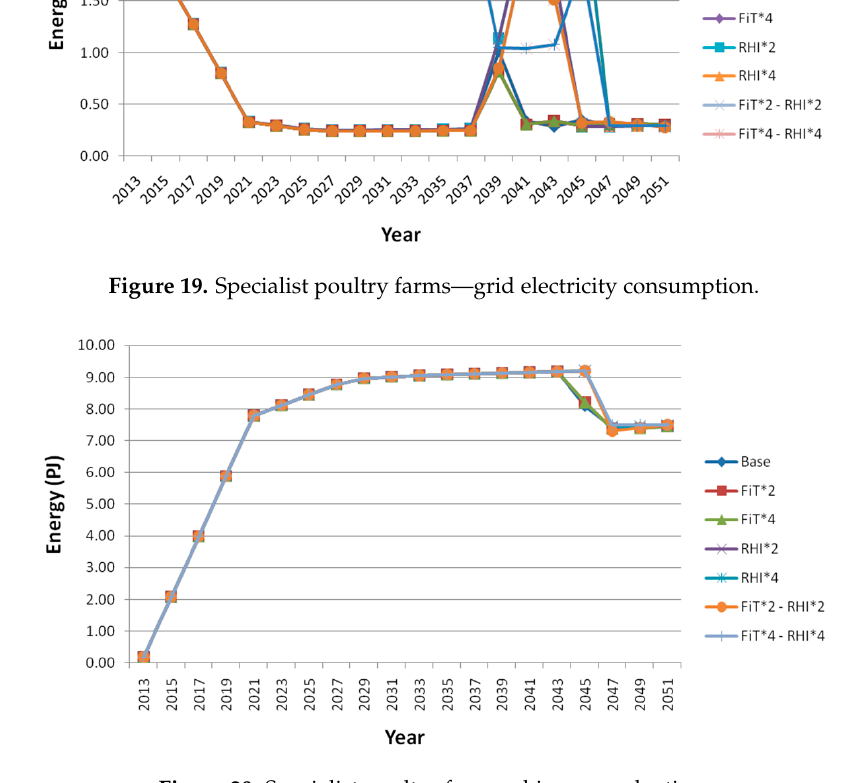
Figure 20. Specialist poultry farms—biogas production.